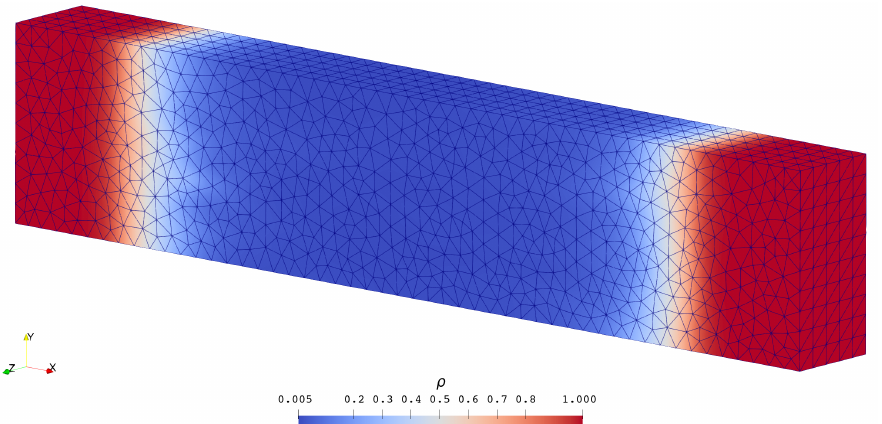
Figure 6. Third-order solution of ρ ( t = 0.4 ) in Problem